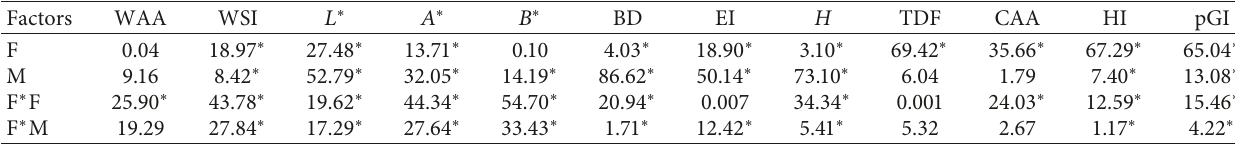
Table 3: Contribution of each factor (%), according to ANOVA, to the physicomechanical properties (TDF, CAA, HI, and pGI) of extruded collets from oca flour mixed with oat fiber † .